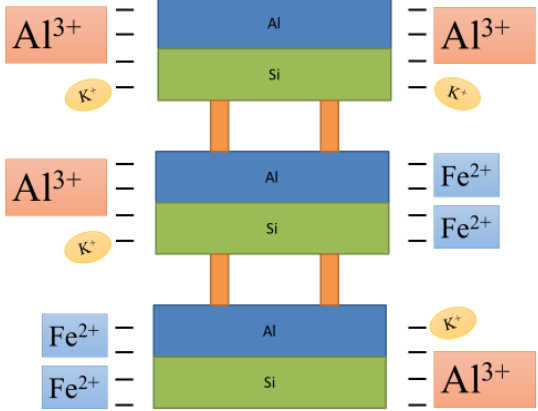
Figure 2. Conceptualisation of kaolinite’s low negative charge density and high level of aluminium and iron ions in acid soils, hindering potassium ion retention.